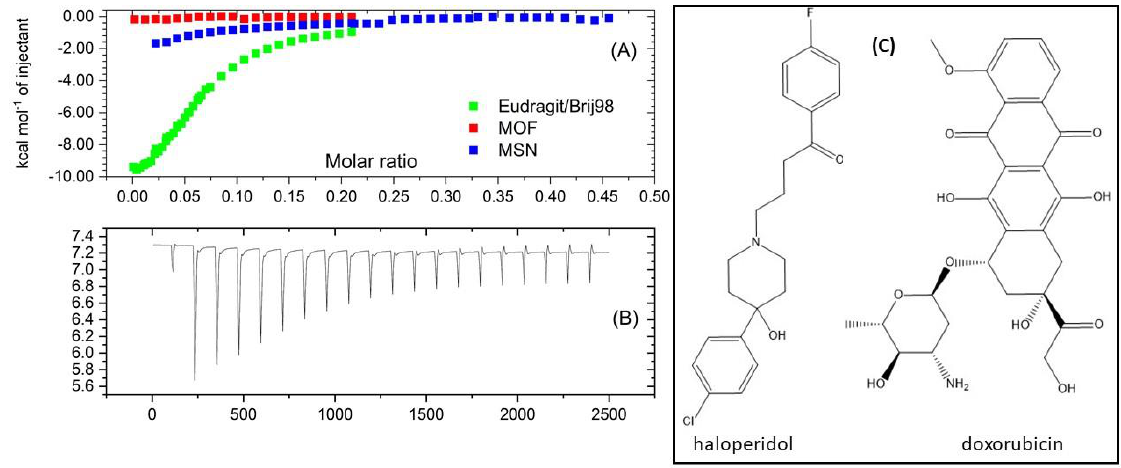
Figure 3. Left: ITC enthalpograms for the titration of Haloperidol in MSN, MOF, and Eudragit/Brij98 solutions ( A ) together with a typical titration curve of haloperidol injection to the solution of Eudragit/Brij98 ( B ). Right: the chemical structures of haloperidol and doxorubicin ( C ).